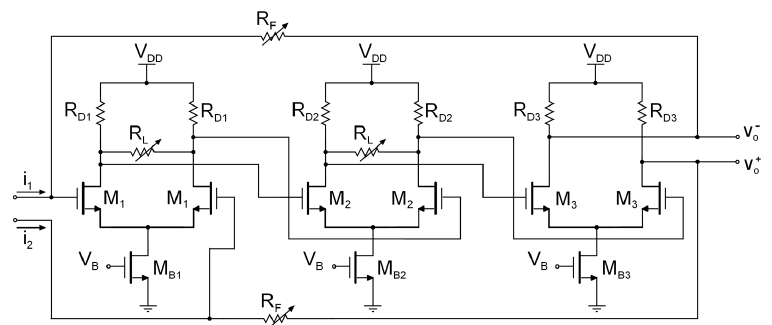
Figure 5. Simplified schematic circuit of the proposed transimpedance amplifier.